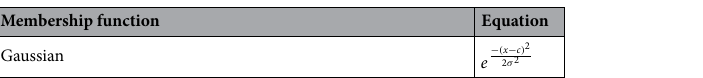
Table 2. Gaussian membership function equation in GAFIS learning process.